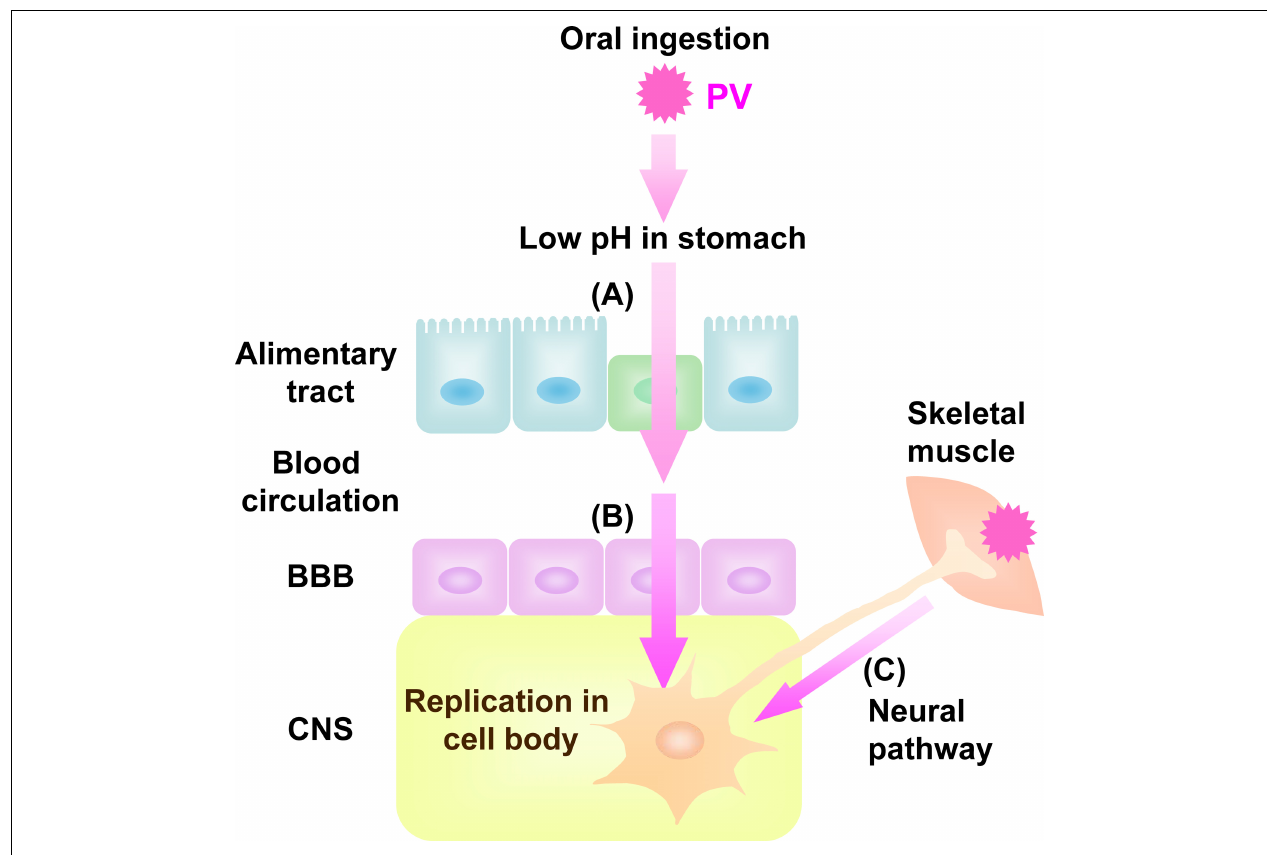
FIGURE 1 | Dissemination pathway for PV in human. Oral ingested PV invades into blood through alimentary tract (A) followed by viremia.The virus in the blood permeates BBB into CNS (B) . PV also invades into CNS directly by neural pathway through MNs from skeletal muscle to CNS (C)